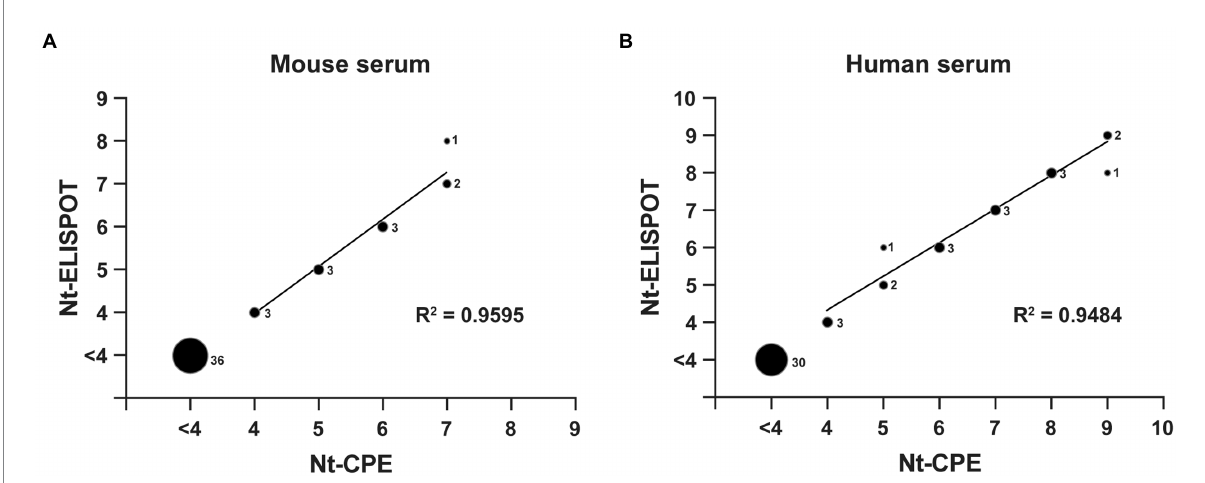
FIGURE 5 Comparison of the Nt-CPE and the Nt-ELISPOT. A total of 48 mouse serum samples (A) and 48 human serum samples (B) were serially diluted in serum-free DMEM and tested using both Nt-CPE and Nt-ELISPOT for comparison. The relative size of each spot corresponds to the number of serum samples, as indicated. The neutralization titers were Log2-transformed. Serum with a neutralization titer less than 4 (Log2-transformation) was excluded from the linear regression